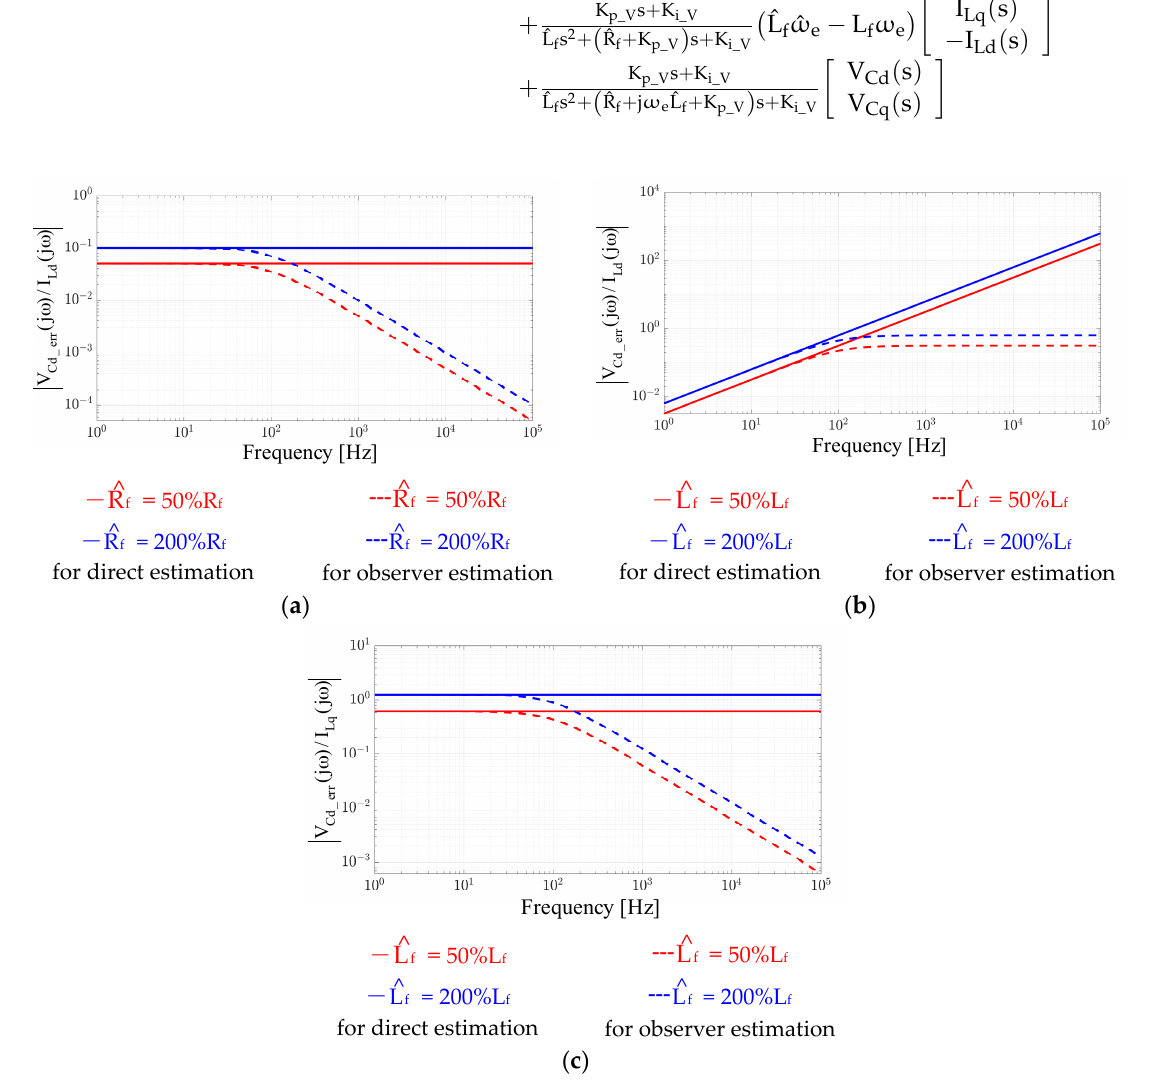
Figure 3. Estimation accuracy evaluation of ˆV Cdq between direct estimation in (4) and proposed observer in Equation (9): ( a ) R f error on |V Cd_err (j ω )/I Ld (j ω )|, ( b ) f error on |V Cd_ err (j ω )/I Ld (j ω )|, and ( c ) f error on |V Cd_err (j ω )/I Lq (j ω )|.